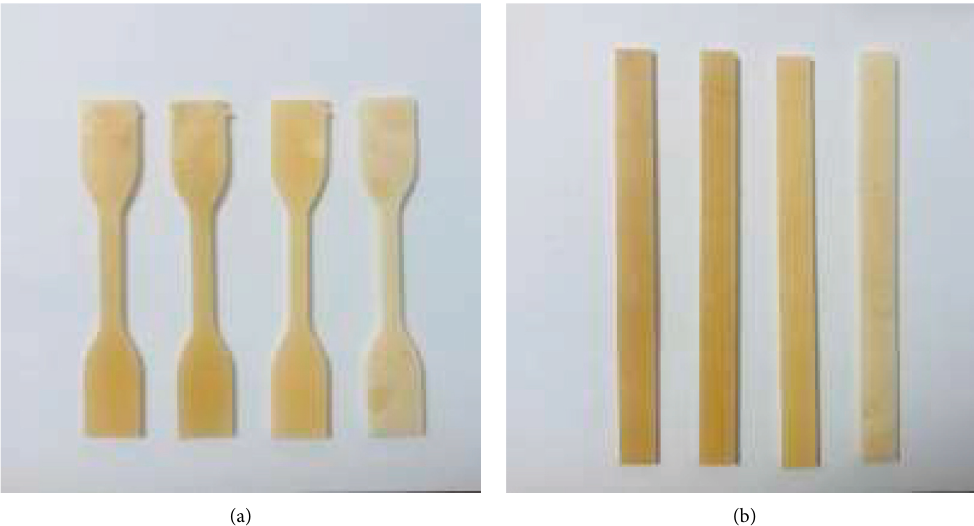
Figure 1: Neat biobased epoxy and FF-SS-reinforced biobased epoxy specimens were prepared for (a) tensile test, and (b) three-point bending test.